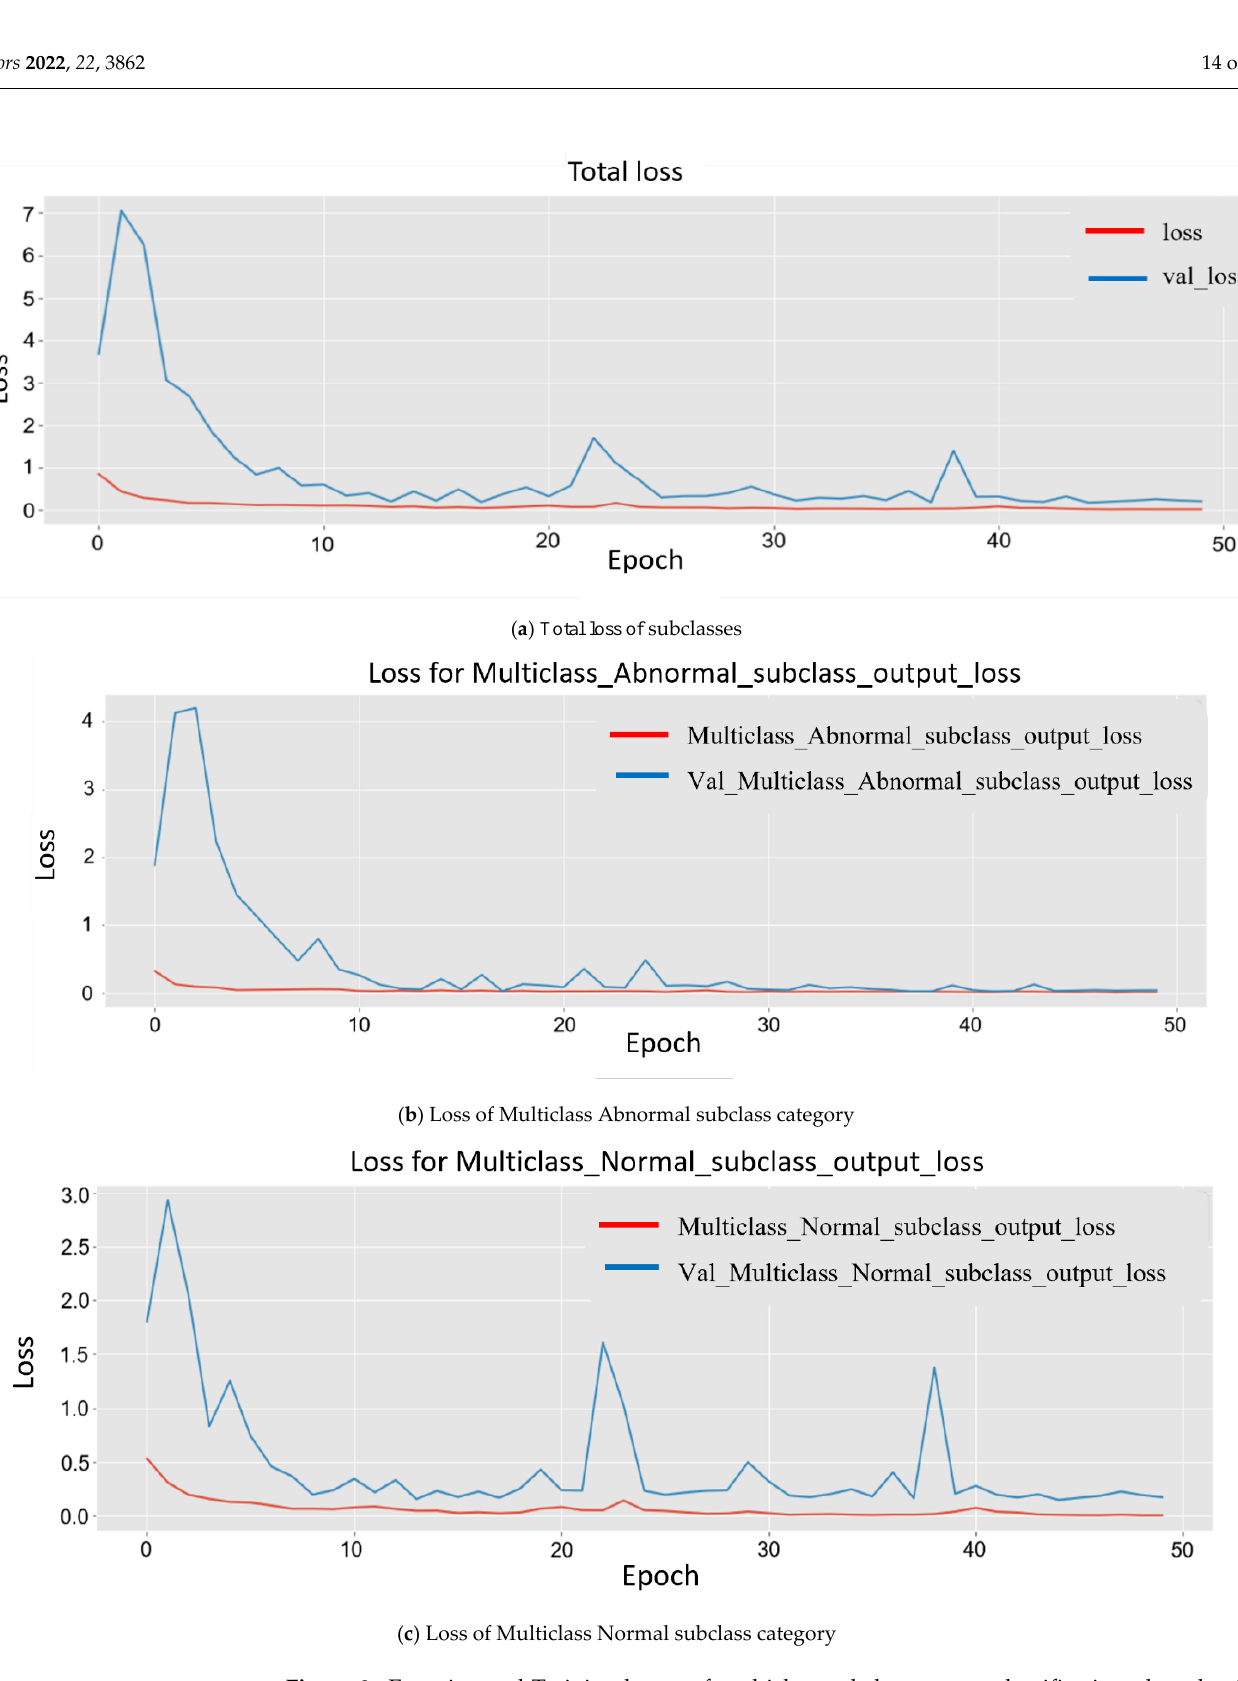
Figure 9. Experimental Training losses of multiclass subclass output classification plotted using matplotlib. They are plotted differently for analysis.